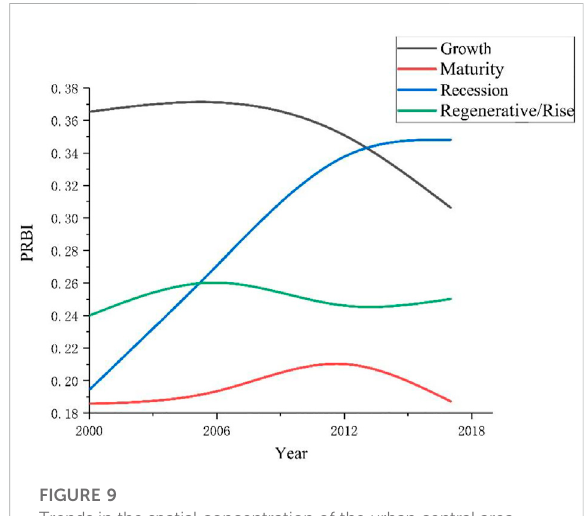
FIGURE 9 Trends in the spatial concentration of the urban central area of RBCs at different periods of